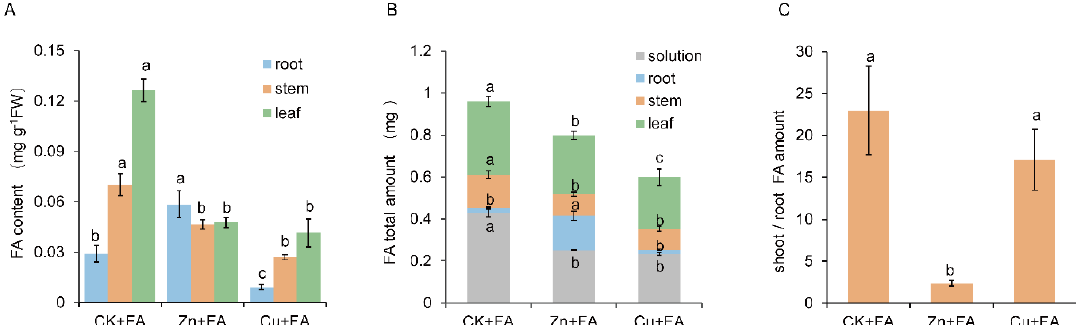
Figure 2. Zinc and copper had different effects on fusaric acid (FA) absorption and distribution in plants. ( A ) FA content in the root, stem and leaf of differentially treated cucumber plants. ( B ) The total amount of FA in plant tissues and nutrient solutions. ( C ) The ratio of shoot to root FA content. Bars represent standard deviation with four replications each. Different letters indicate significant differences ( p < 0.05, Duncan’s multiple range test) of the same tissue with different treatments. Int. J. Mol. Sci. 2020 , 21 , x FOR PEER REVIEW